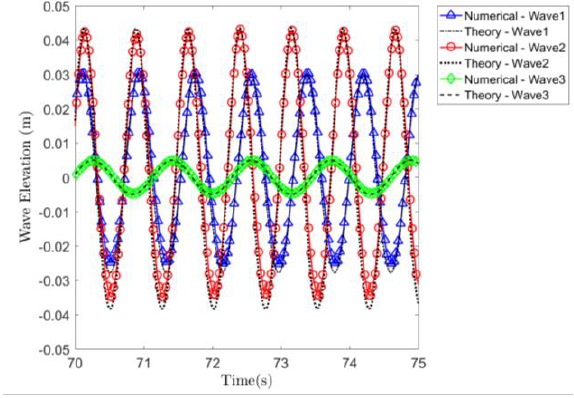
Figure 12. Surface elevation of Wave 1, 2 & 3 in deep water conditions at location 4m downstream of inlet.